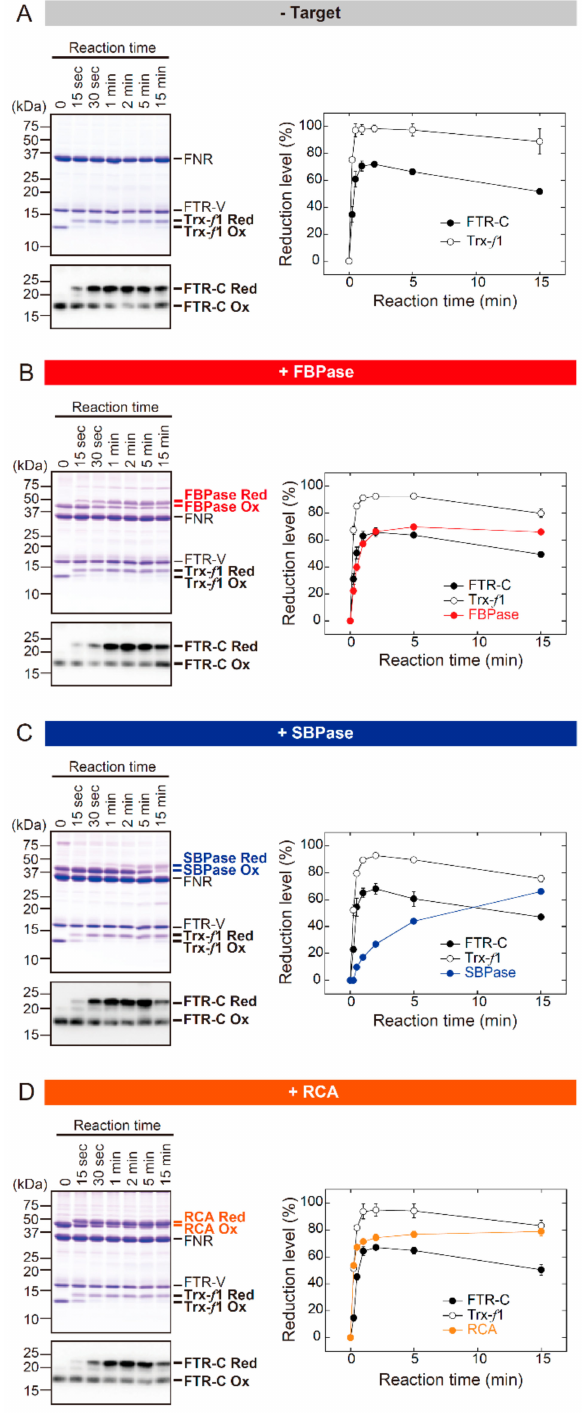
Figure 1. The in vitro redox responses of FTR-C, Trx- f 1, and target proteins from Arabidopsis (pH 7.5). ( A ) Experiments were performed under target-free conditions. ( B – D ) FBPase ( B ), SBPase ( C ), or RCA ( D ) was used as the target. Each of the oxidized proteins (2 µ M) was incubated with 1 mM NADPH, 2 µ M FNR and 2 µ M Fd for the indicated time period. Assays were performed at pH 7.5. Following the reaction, proteins were labeled with AMS and subjected to non-reducing SDS-PAGE. Proteins were then stained with Coomassie Brilliant Blue R-250 (CBB). FTR-C was detected by immunoblotting, as its CBB-derived signal was low. The reduction level of each protein was calculated as the ratio